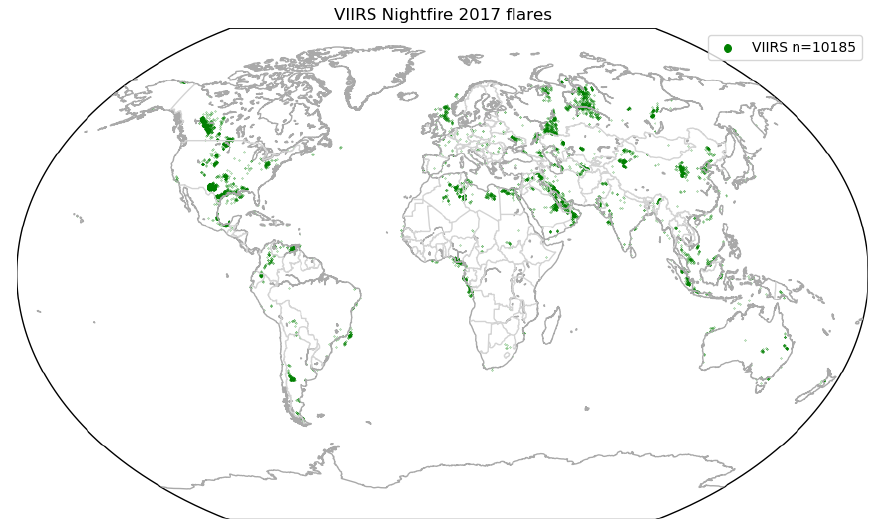
Figure 16. VIIRS Nightfire flaring locations for 2017. We considered every record in the VIIRS Nightfire data as a flare, i.e. “upstream” (10009), “downstream oil” (718), and “downstream gas” (101). After gridding, 10185 cells were populated and are considered flaring sites. A detailed spatial analysis between these locations and those found by our methodology is shown in Fig. 18.